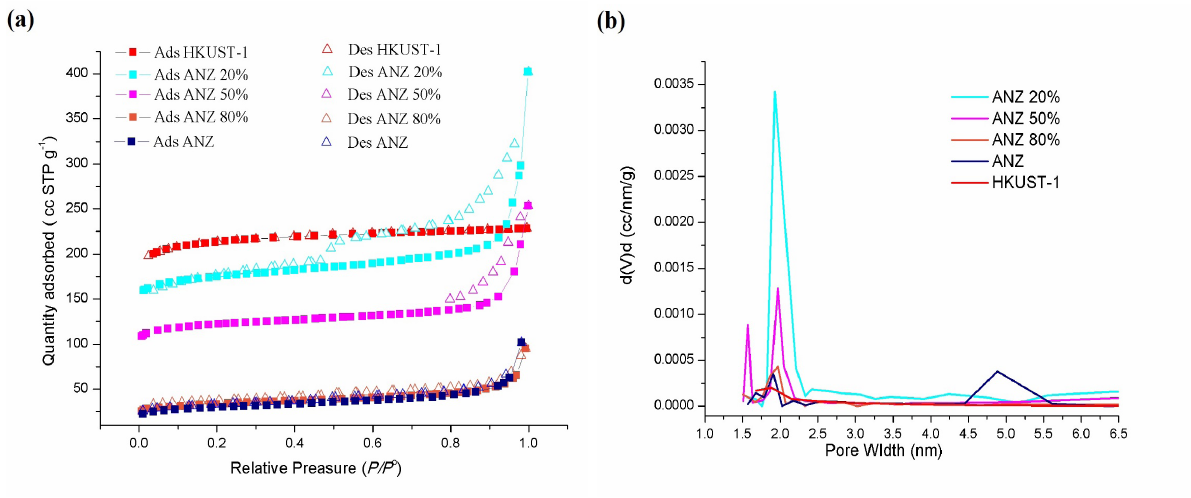
Figure 4 : Nitrogen sorption isotherm (a) and BJH pore size distribution (b) of HKUST-1, ANZ, and the composite ANZ@HKUST-1.